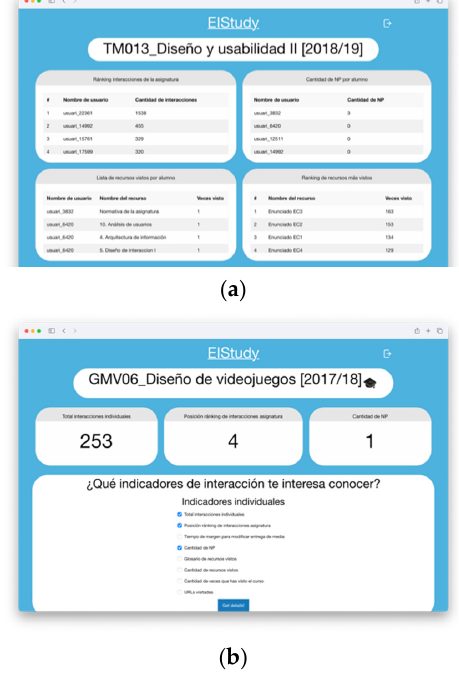
Figure 7. ( a ) EIStudy’s visualization toolL once the user creates a request to the educational ware- house modules, it offers data related to the specified content and its role. If the user is a teacher, he or she will be able to see “individual” values and “group” values, whereas students will only see “individual” values since they are not allowed to see data from other people in that context ( b ).